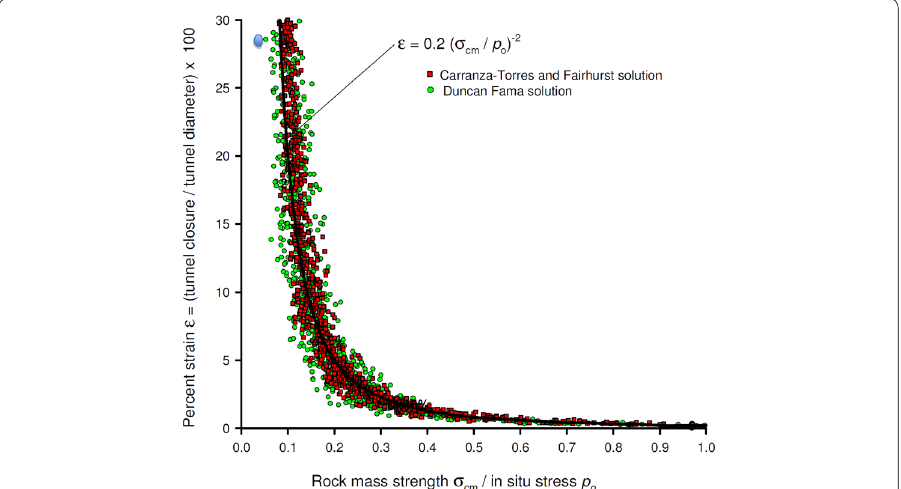
Fig. 8 Plot of tunnel convergence against the ratio of rock mass strength to in situ stress for unsupported tunnels